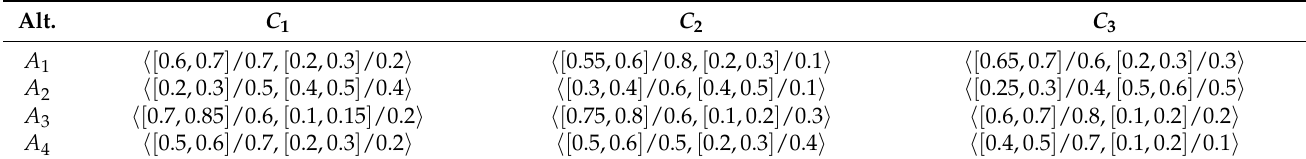
Table 6. Decision matrix R 3 provided by expert e 3 .